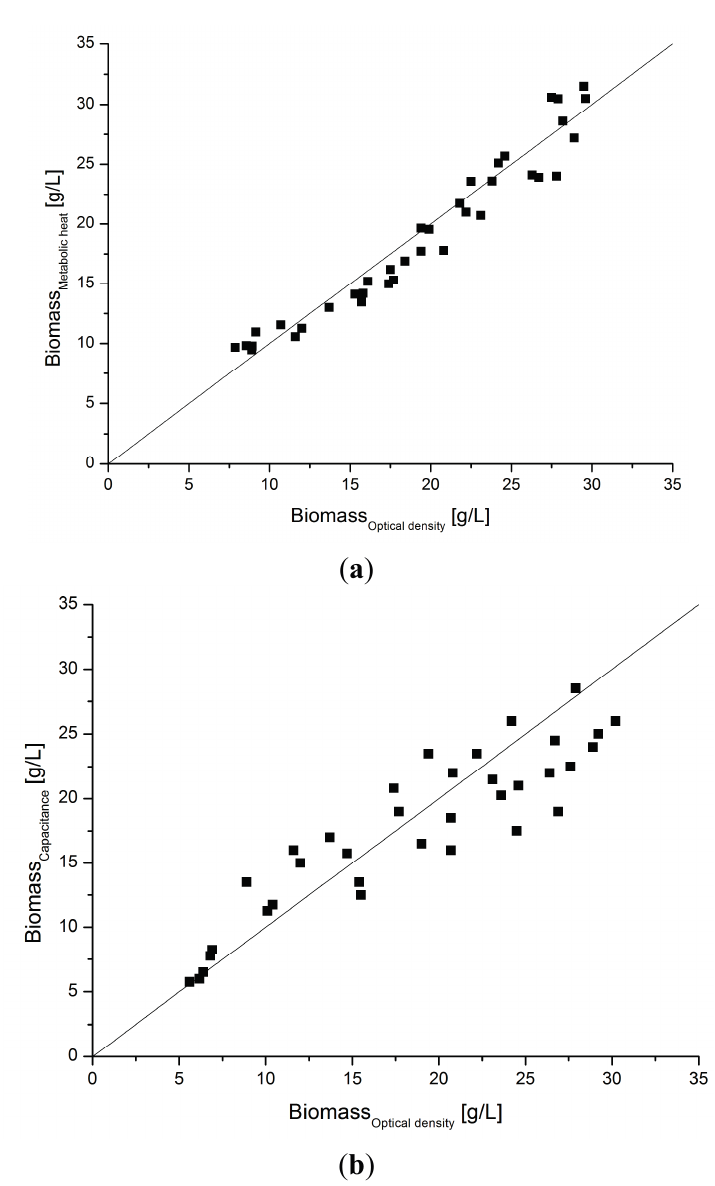
Figure 9. Correlation data collected from four fed-batch cultivations. ( a ) Biomass estimated by the soft sensor model compared with off-line determined biomass; ( b ) Biomass concentration determined by capacitance sensor compared with off-line determined